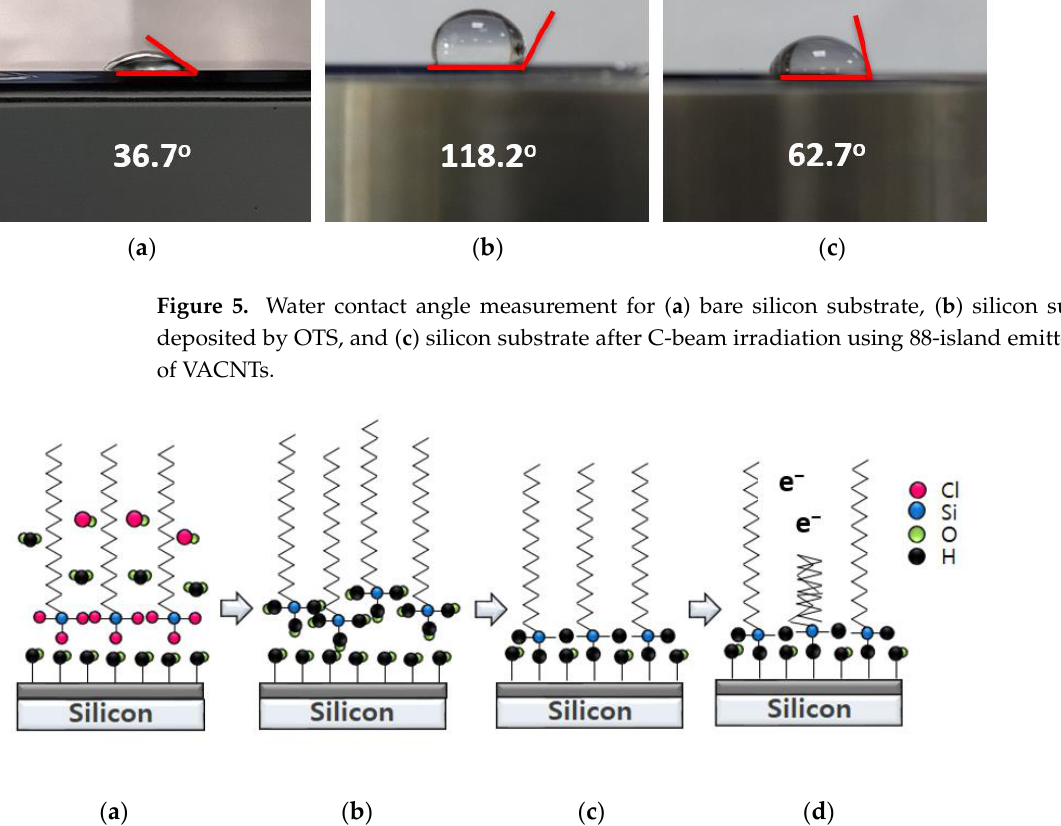
Figure 5. Water contact angle measurement for ( a ) bare silicon substrate, ( b ) silicon substrate deposited by OTS, and ( c ) silicon substrate after C-beam irradiation using 88-island emitter array of VACNTs.